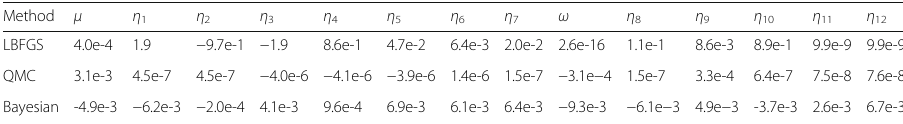
Table 2 The GARCH parameters for the ORI sector Method